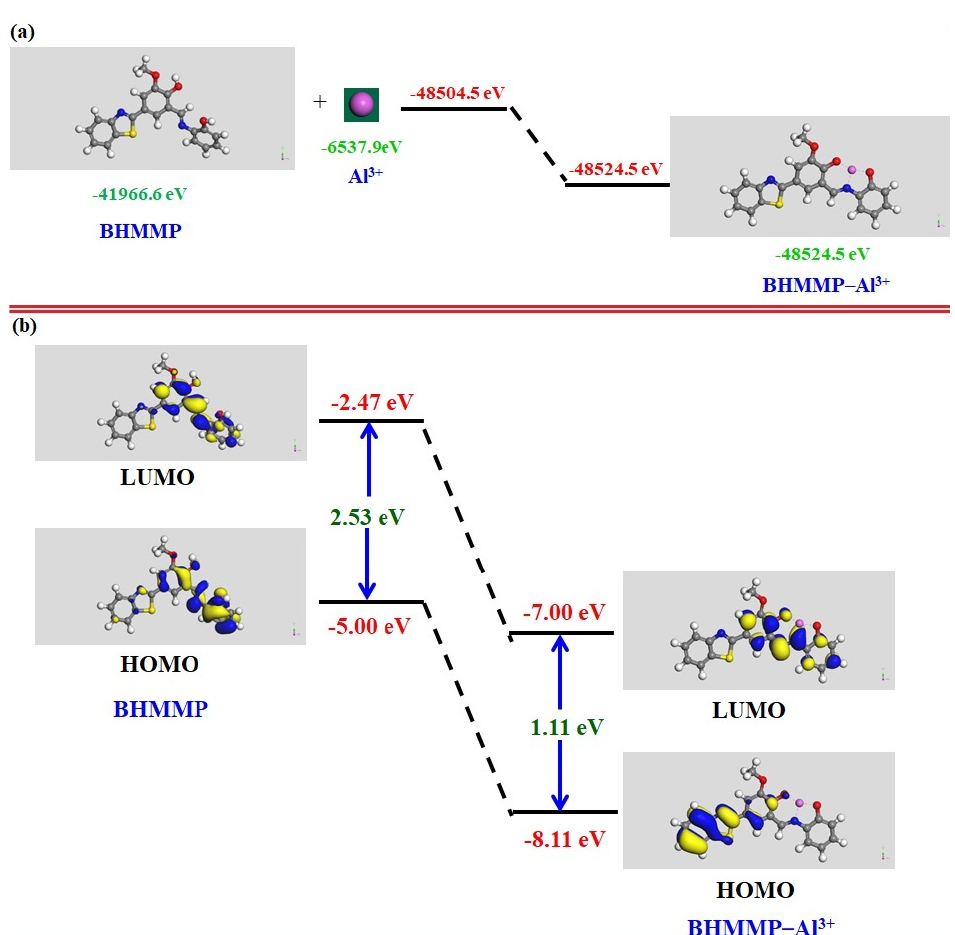
Figure 8. ( a ) Energy optimized structure of probe BHMMP (left) and (BHMMP–Al 3+ ) (right), and ( b ) the corresponding molecular orbital of BHMMP and BHMMP –Al 3+.